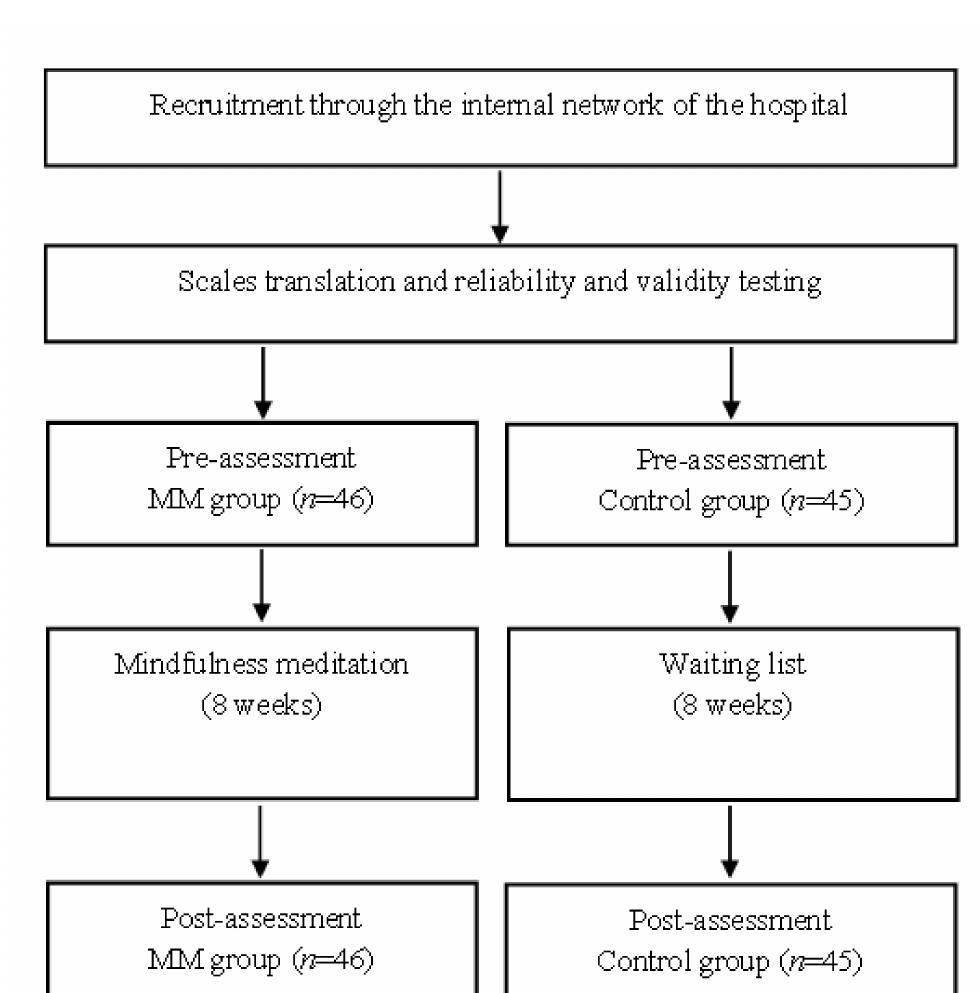
Figure 1. Procedure flow